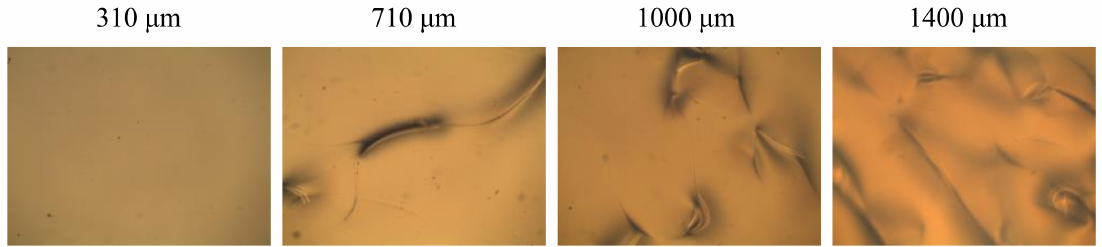
Figure 11. Polarizing optical microscopy pictures of LC cells with LC thicknesses of 310 µ m, 710 µ m, 1000 µ m, and 1400 µ m under parallel